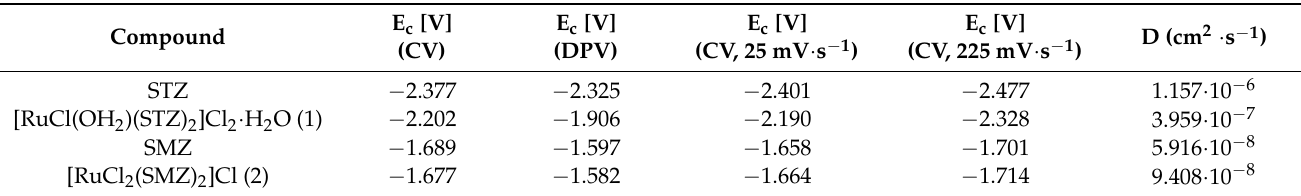
Table 5. Values of cathodic potentials E c of studied compounds in DMSO recorded using CV and DPV and values of the diffusion coefficient